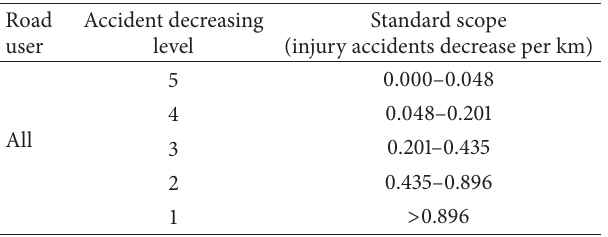
Table 9: Standard of injury accidents decreasing levels.